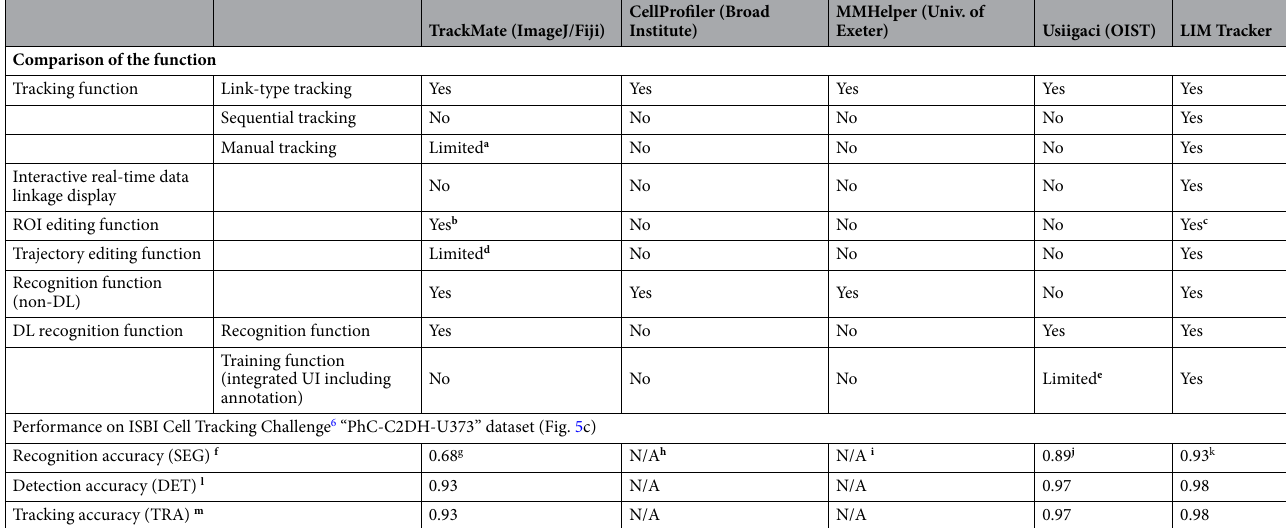
Table 1. Comparison of LIM Tracker with those of the existing software. a, Cannot be combined with other tracking functions. b, The region shape cannot be set. c, The region shape can also be freely set. d, It